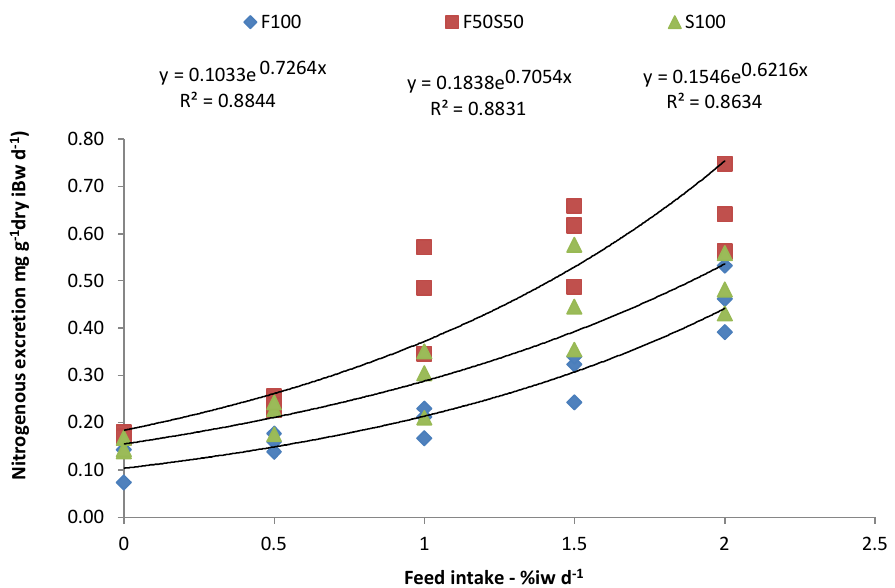
Figure 2. Relationships between fecal production of juvenile crabs and ingested feed for the three experimental diets. Amount of feed intake was percentage of initial fresh body weight (iBW) per